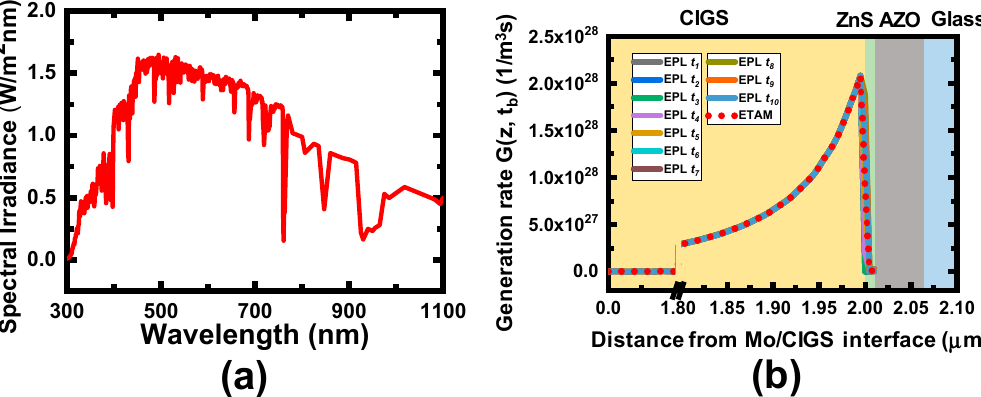
Figure 6. ( a ) Spectral irradiance of air mass (AM) 1.5 sunlight ranging between 300 and 1100 nm used in this calculation. ( b ) Calculated spatial profiles of the generation rate in the longitudinal z-direction G ( z , t b ) with respect to 10 di ff erent equispaced phase thicknesses of t 1 , t 2 , ··· and t 10 . The ETAM-applied generation rate in the longitudinal z-direction G ETAM ( z ) was plotted along the red dotted line. The generation rate was obtained by integrating the optical power dissipation weighted by the spectral irradiance of AM 1.5 sunlight. Table 1. Simulation parameters used in the electrical modeling [24].